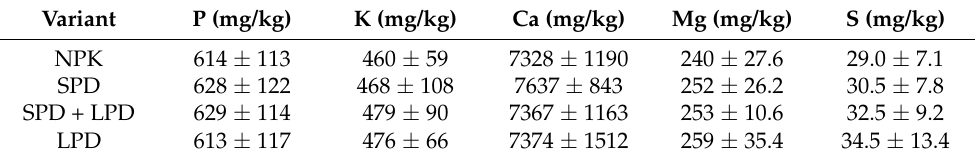
Table 10. Macronutrient content in soil samples after harvest of plants in dry matter.